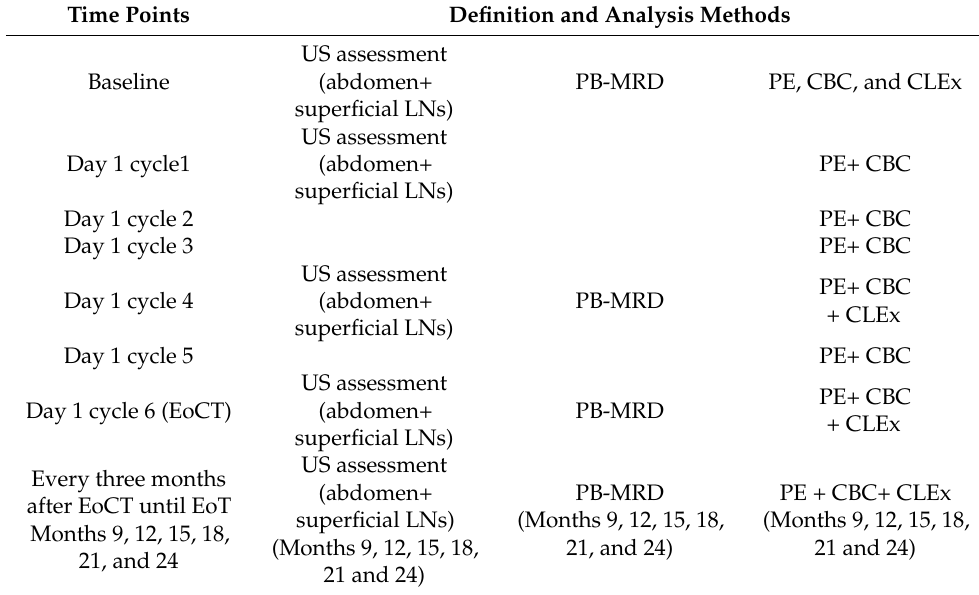
Table 1. Definition of study timepoints and timing of analysis